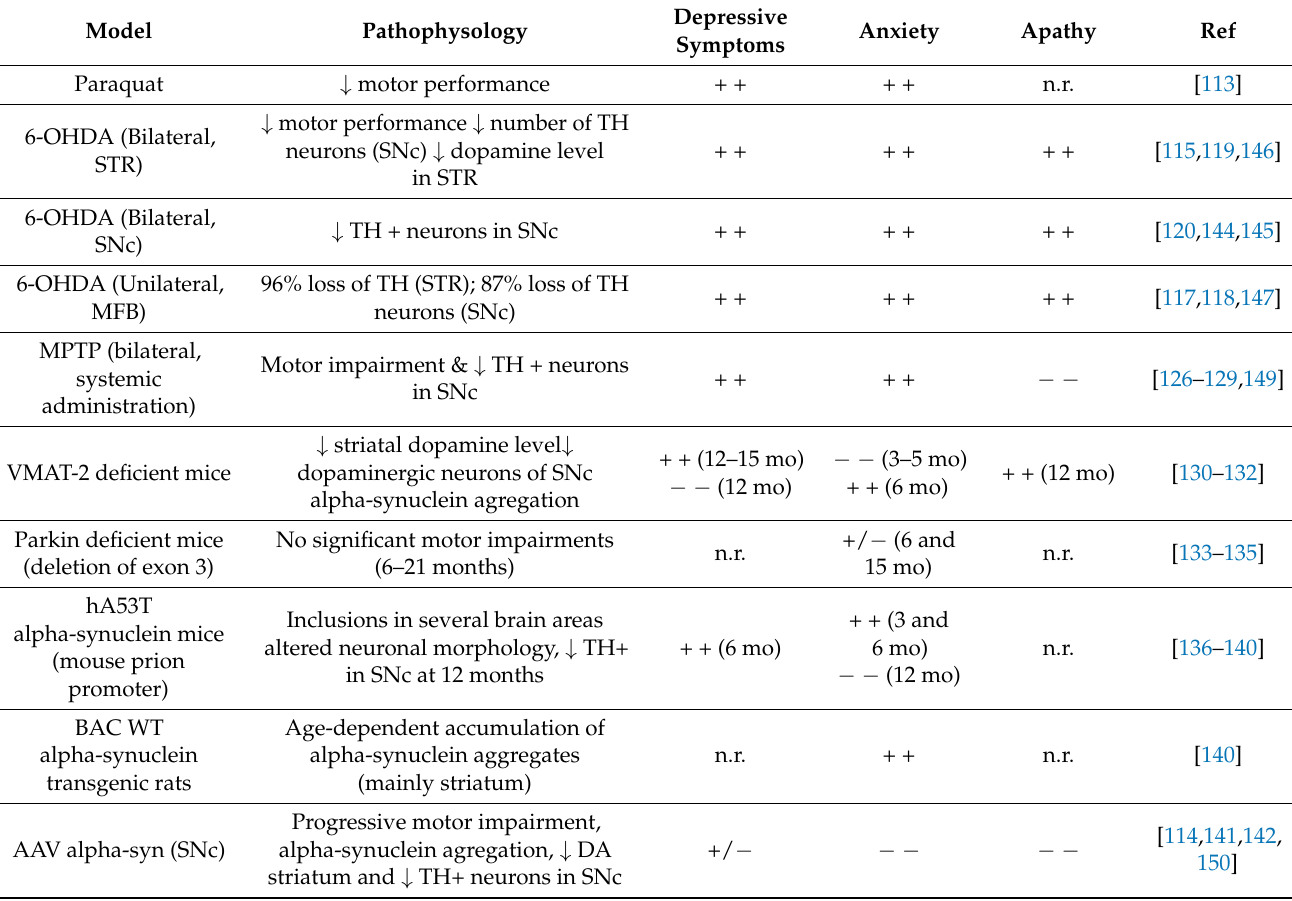
Table 1. Overview of neuropsychiatric deficits in rodent models of PD. ↓ = decrease, − − = absence, +/ − = presence or absence depending on studies, + + = presence, n.r. = non reported, mo = months.